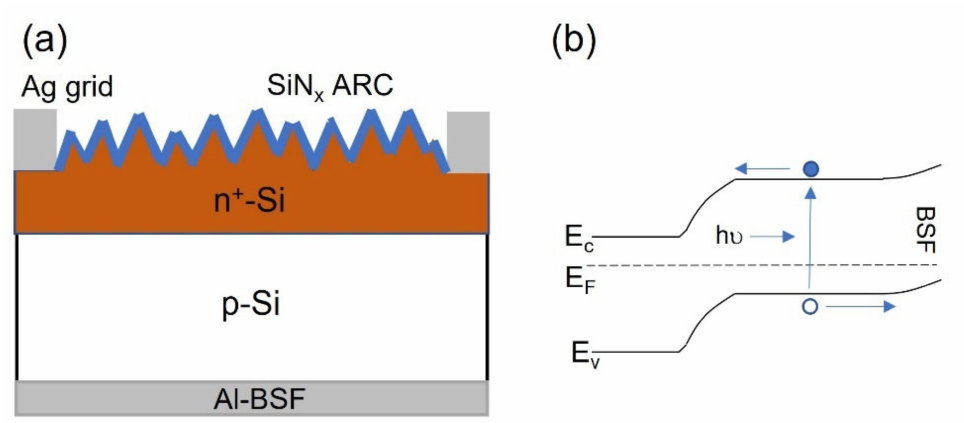
Figure 1. ( a ) Schematic cross-sectional diagram of a p-type Al-BSF c-Si solar cell with surface texturing; ( b ) energy band diagram of p-type Al-BSF solar